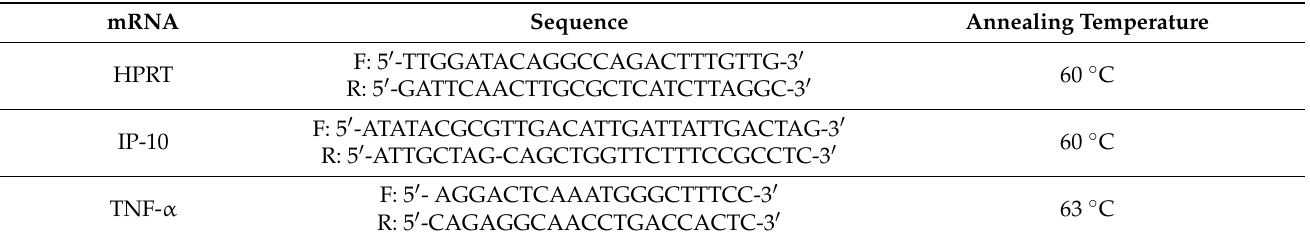
Table 2. Selected primers for